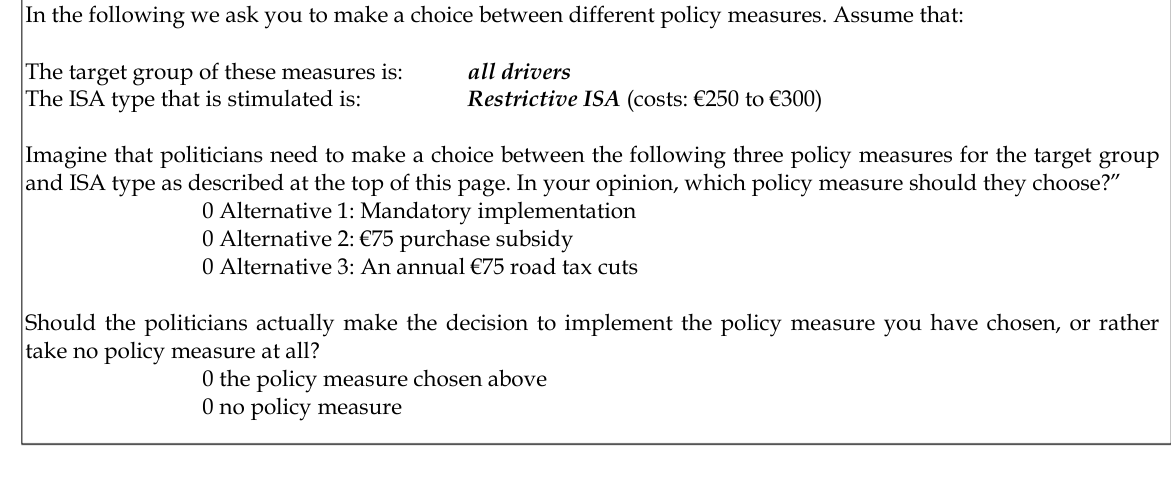
Figure 1. Example of measurement